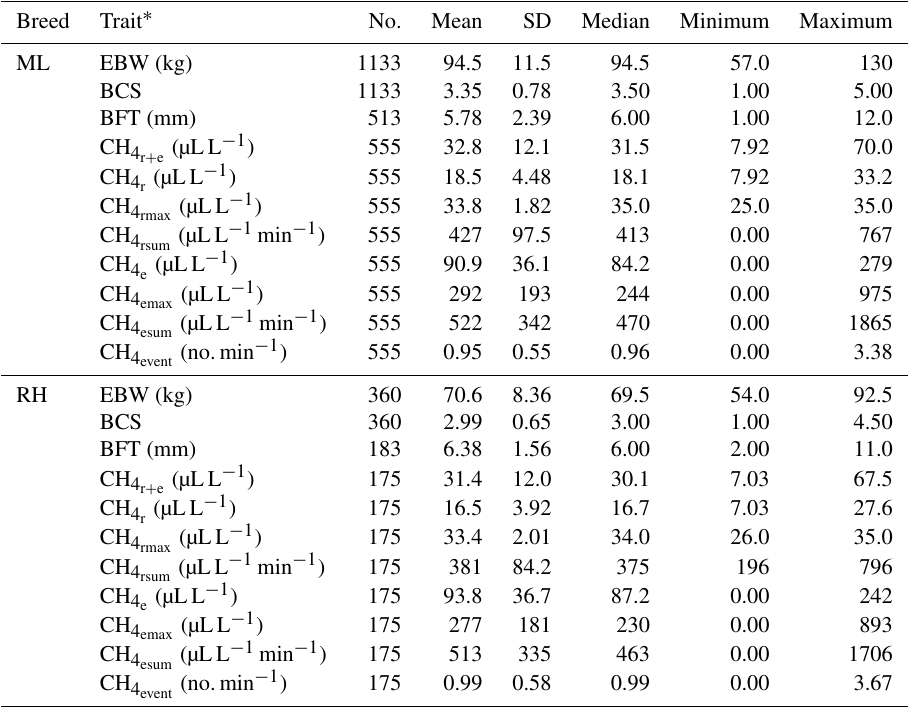
Table 1. Descriptive statistics for ewe body weight (EBW), ewe body condition score (BCS), ewe backfat thickness (BFT) and CH 4 traits in the breeds Merinoland (ML) and Rhön sheep